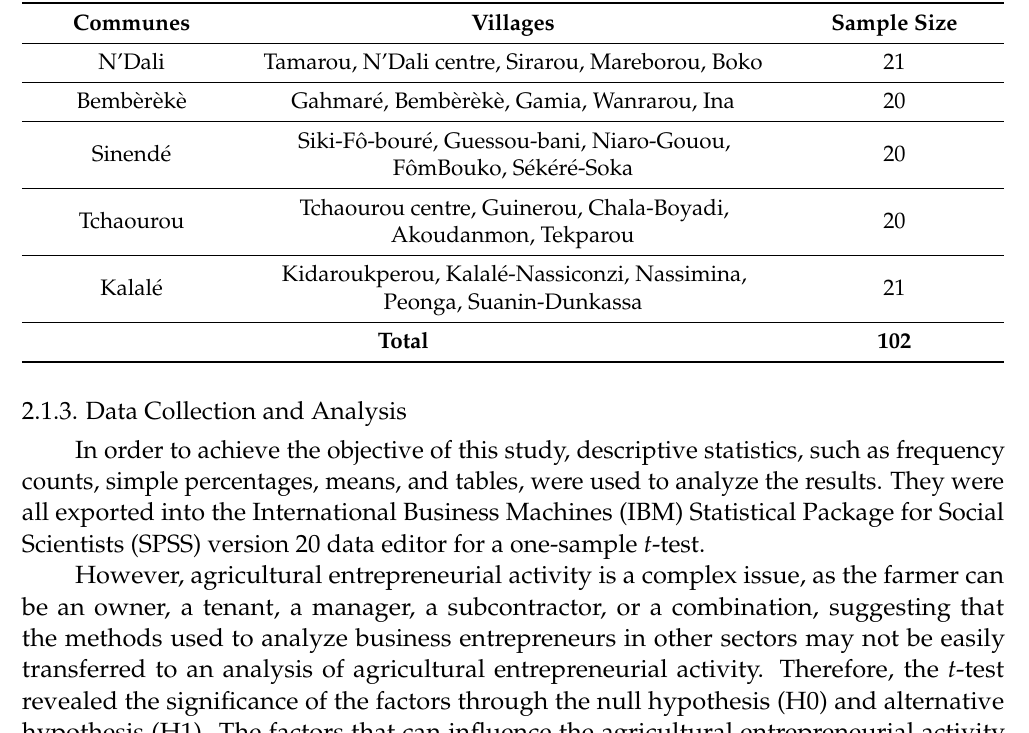
Table 2. Study area and